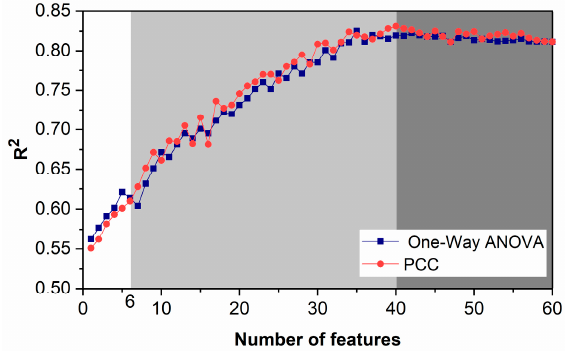
Figure 5. The accuracy of PLSR model established by single feature ranking algorithms.